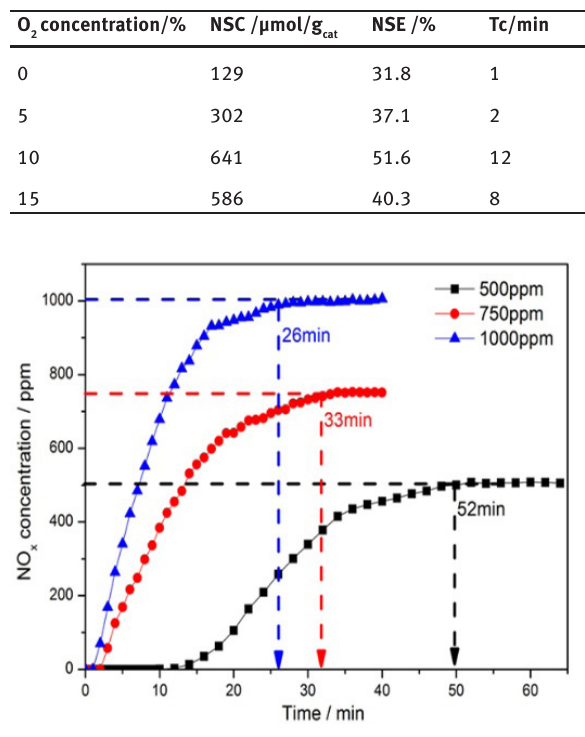
(NO/NO ) breakthrough profile for 65 min at different Figure 7: NO x 2 NO concentration with lean feed consisting of 500 ppm NO+balance N , 60,000 h -1 2